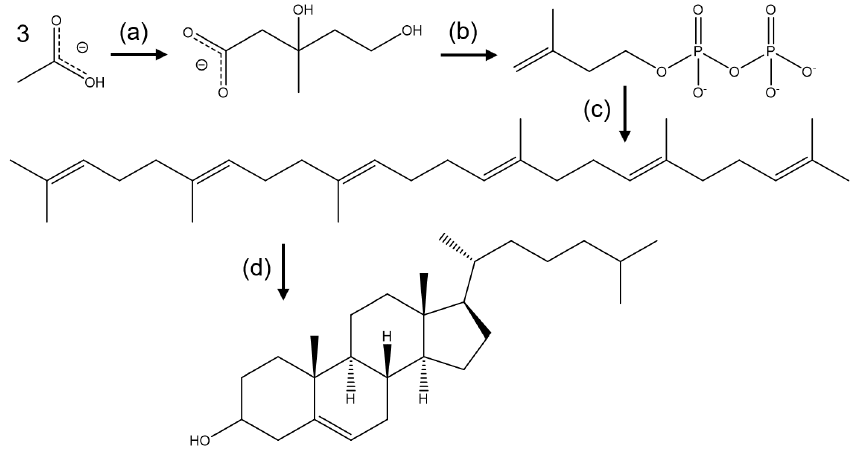
Figure 3. Summary of cholesterol biosynthesis. ( a ) Synthesis of mevalonate from acetate; ( b ) Conversion of mevalonate to activated isoprenes; ( c ) formation of squalene; ( d ) conversion of squalene to form the ring steroid nucleus.